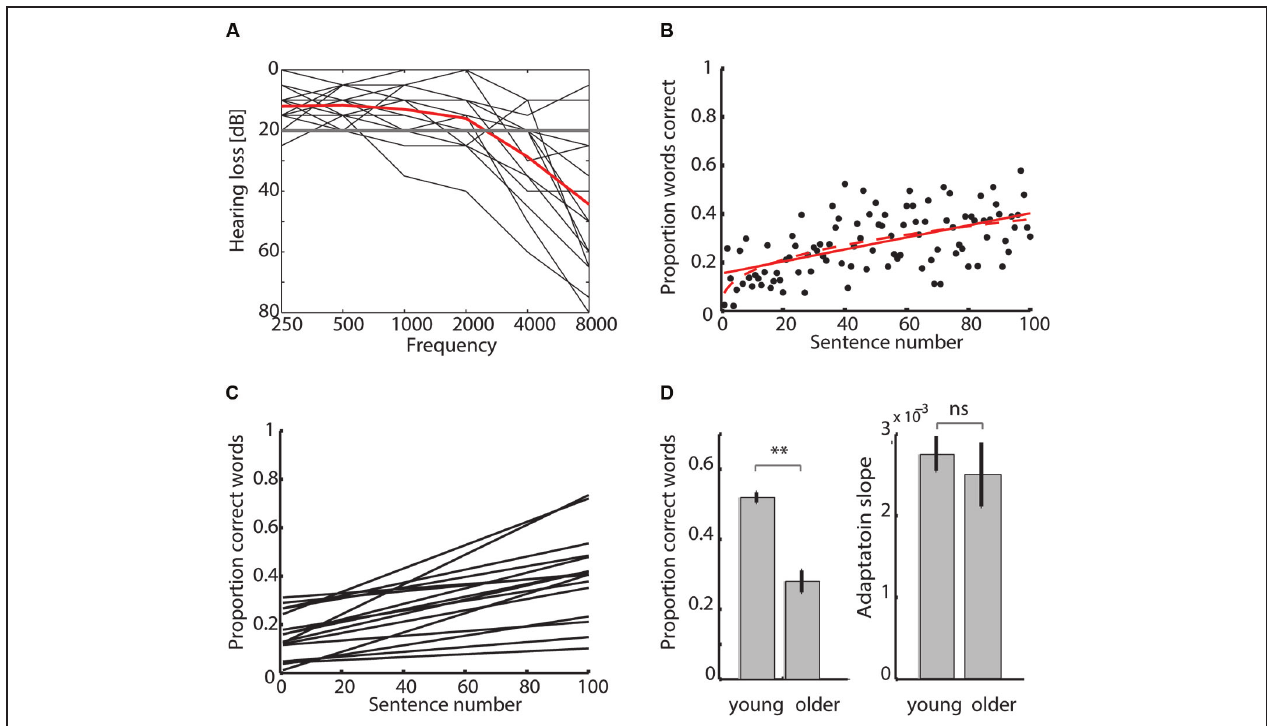
FIGURE 1 | (A) Audiograms of older adults. Older participants are affected by varying degrees of sensorineural hearing loss. Hearing loss for each participant’s better ear (black line) and mean over all participants (red line) are shown. (B) Mean report scores (averaged over all older participants) with a linear (red solid line) and power law fit (red dashed line). (C) Older adults’ adaptation curves. Linear fits to report scores show individual